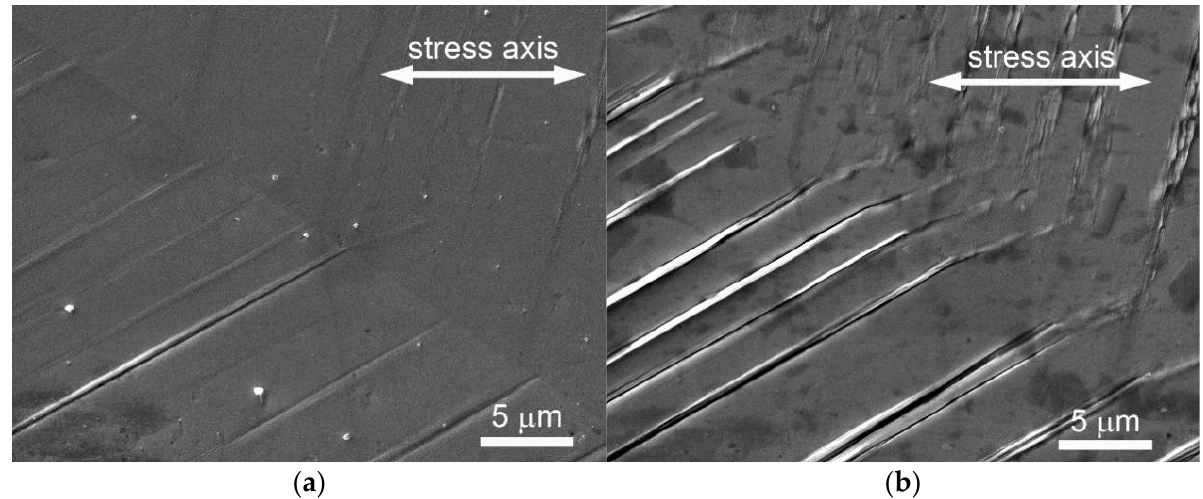
Figure 1. Evolution of PSMs in a grain of polycrystalline copper cycled with low strain amplitude ( ε a = 1 × 10 −3 ), N f = 10 5 ( a ) N = 5% N f , ( b ) N = 50% N f .